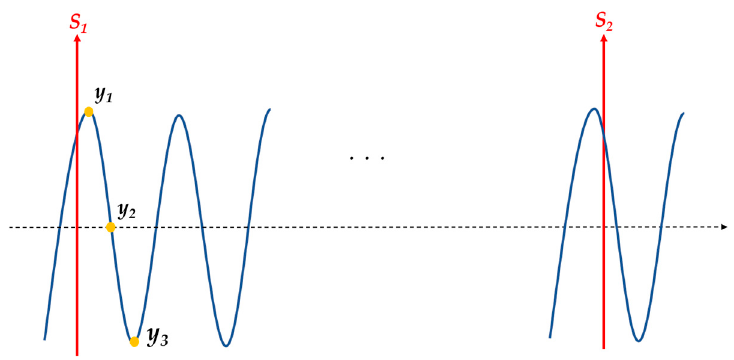
Figure 4. The positions of three detection points (